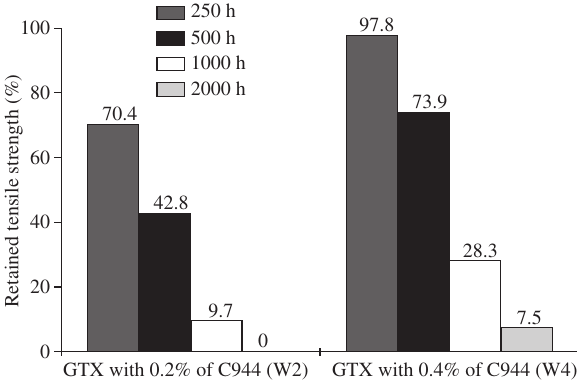
Figure 6 Elongation at maximum load of the GTXs W2 and W4 before and after artifi cial